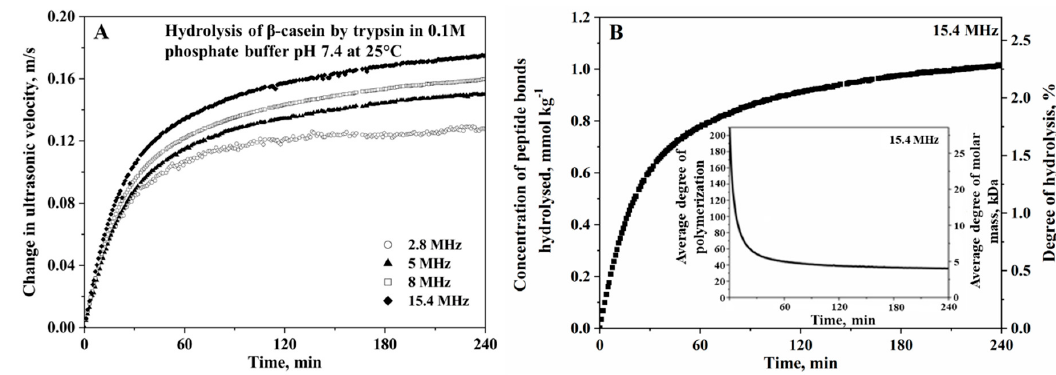
Figure 9. ( A ) Ultrasonic velocity profiles of the hydrolysis of β -casein treated with trypsin in 0.1-M phosphate buffer, pH 7, at 25 °C, measured at four different frequencies. ( B ) The corresponding hydrolytic profiles translated from ultrasonic velocity profiles in Figure 9A using ∆ a r ( = 0.115 kg mol − 1 ) determined from ultrasonic calibration with the trinitrobenzene sulfonic acid (TNBS) assay method. The concentration of the peptide bonds hydrolyzed (primary y-axis) is calculated using Equation (9), and the corresponding degree of hydrolysis (secondary y-axis) is calculated using the second Equation (13). The insert presents the reduction of the average degree of polymerization (primary y-axis) and average molar mass (secondary y-axis) calculated from the concentration of the peptide bonds hydrolyzed using Equation (14). The protein concentration is 5 mg mL − 1 , and the concentration of enzymes is 0.41 µ M. Reproduced with permission of Elsevier from Melikishvili et al. [104].